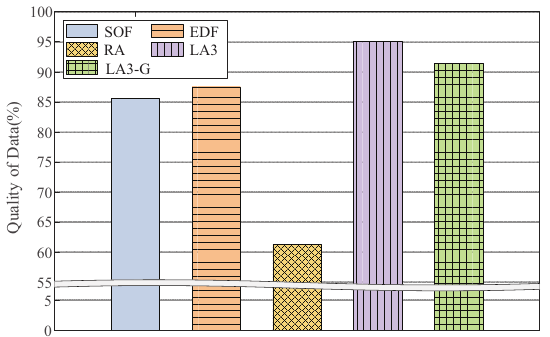
Figure 15. Performance of the generative model for action transformation: LA3-G and LA3 share the same structure for two-step action embedding, except that LA3-G exploits the generative model in Figure 7, but LA3 exploits the user-defined function.